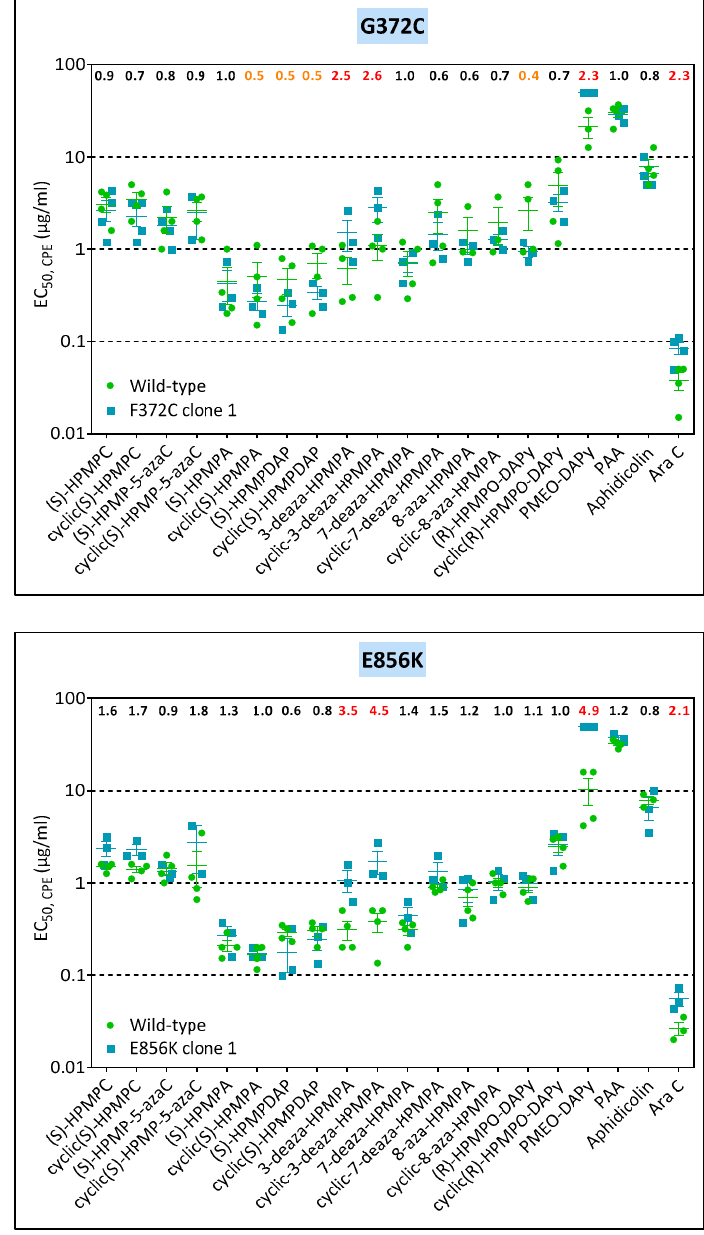
Figure 9. Drug-susceptibility profile of PAA-R viral clones ( A ) and PMEO-DAPy-R viral clones ( B ). Drug-resistance properties of the different viral clones were determined using a CPE reduction assay with HEL fibroblasts. The effects of different drugs on viruses encoding the indicated mutations were determined by calculating the EC 50 values for the parental wild-type strain and clones bearing the specific mutations. At least two independent experiments were performed for each test compound. Horizontal lines for each drug and mutant viral clones indicate the mean values ± standard deviation. The fold resistance (ratio of the EC 50 for the mutant viruses to the EC 50 for the corresponding wild-type virus is marked at the top of the graph. VACV viral clones showing a ≥ 2-fold increase (red) were considered drug resistant (R) and those with a ≤ 0.5-fold decrease (orange) were considered drug hypersensitive (hs).